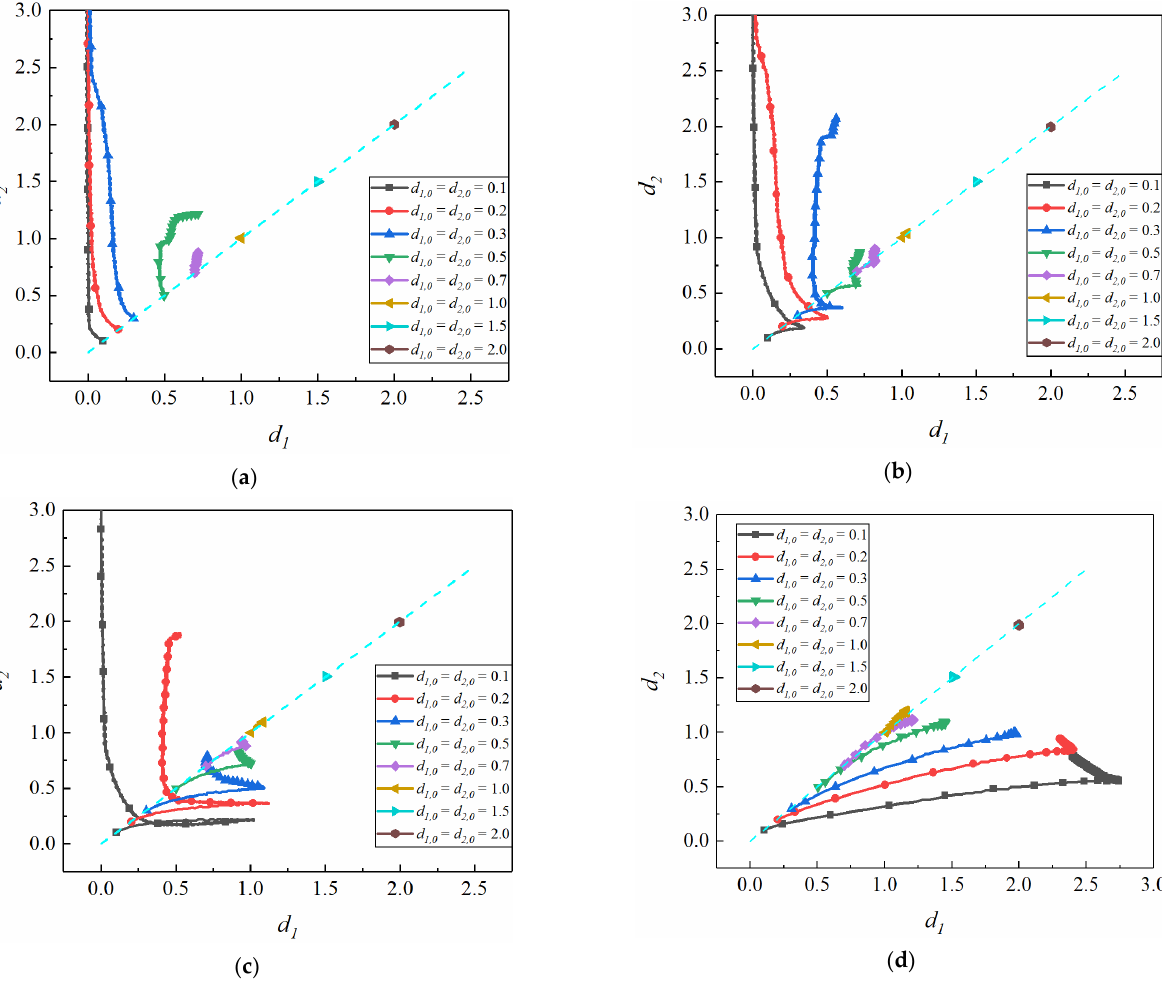
Figure 3. Diverse variations of interparticle distances for different initial interparticle distances. ( Wi = 0.5, α = 0.1, η r = 0.3, ε = 0.3). ( a ) y 0 = 0; ( b) y 0 = 0.1; ( c ) y 0 = 0.15; ( d ) y 0 = 0.2.